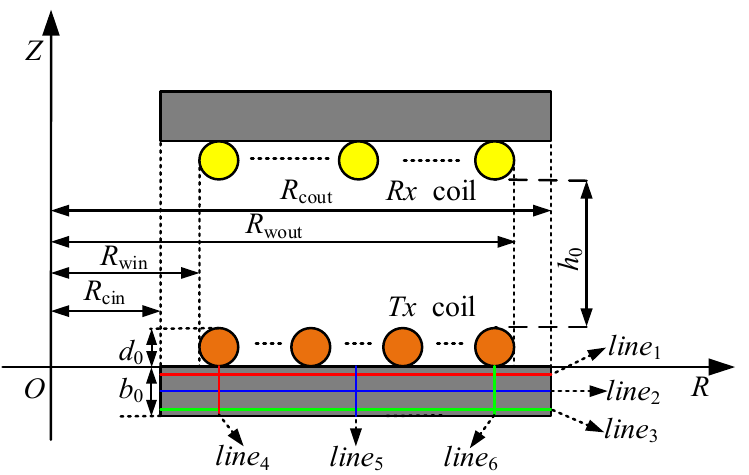
Figure 1. The simulation model of the magnetic coupling system. Table 1. The parameters and setup of magnetic coupling system.